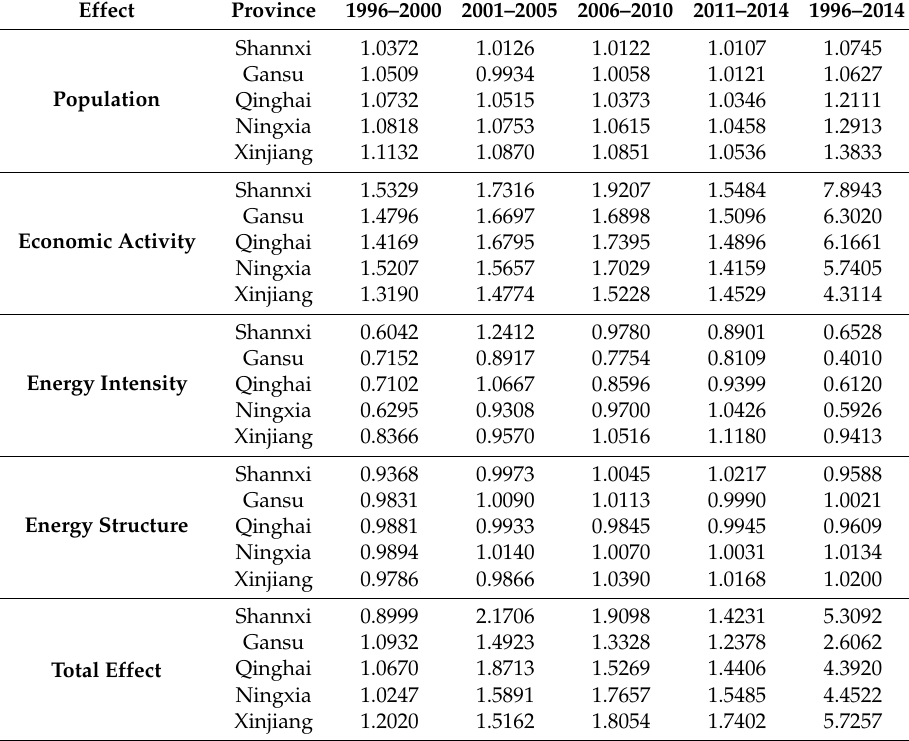
Table 3. Multiplicative LMDI decomposition of CO 2 emissions in different